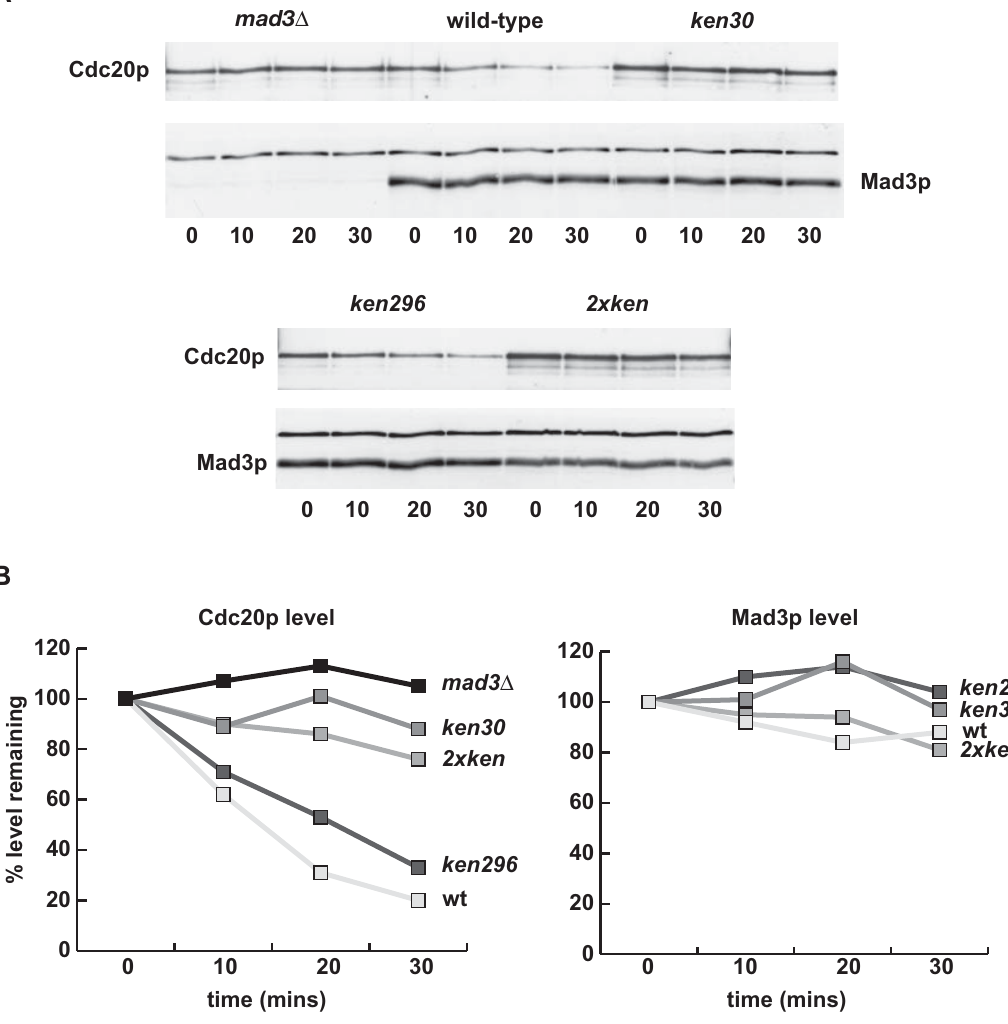
Figure 5. mad3-KEN30AAAstabilises Cdc20p in mitosis. A) Strains were arrested in mitosis (with nocodazole and hydroxyurea), and cycloheximide was added (time 0) to prevent new protein synthesis. Time points were taken and immunoblotted for Cdc20p levels (anti-myc) and Mad3p levels. B) Quantitation of the Cdc20p and Mad3p levels.